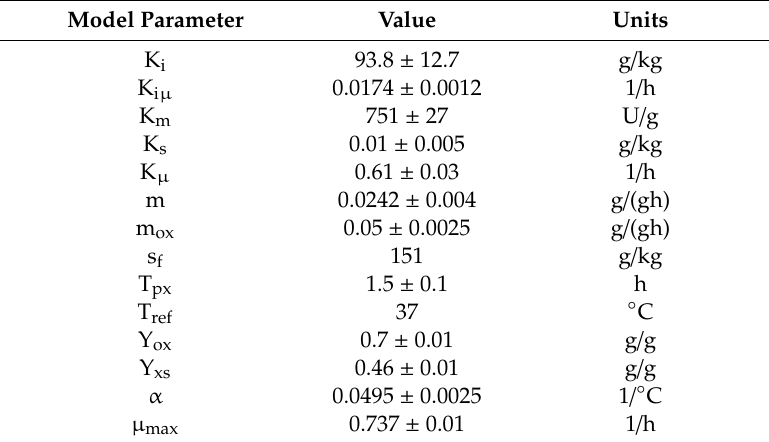
Table 1. Values of the model